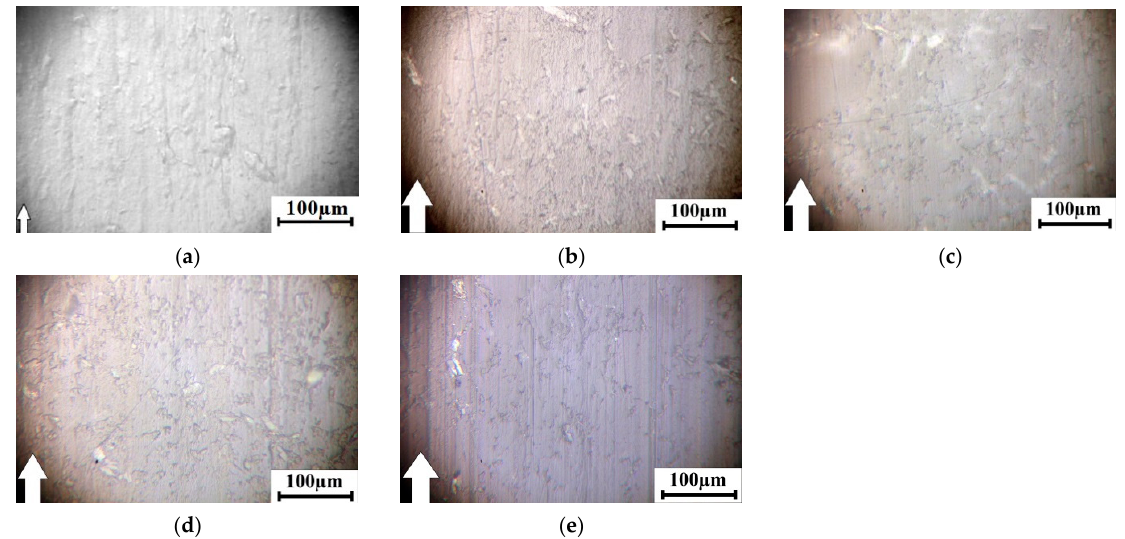
Figure10. OpticalimagesoftheweartracksurfacesofneatUHMWPE( a ); andthe“UHMWPE + 23wt.% wollastonite” composites: untreated ( b ); “KH-550” ( c ); “Penta-1006” ( d ); and “OTS” ( e ) (Load = 60 N, Velocity = 0.3 m · s − 1